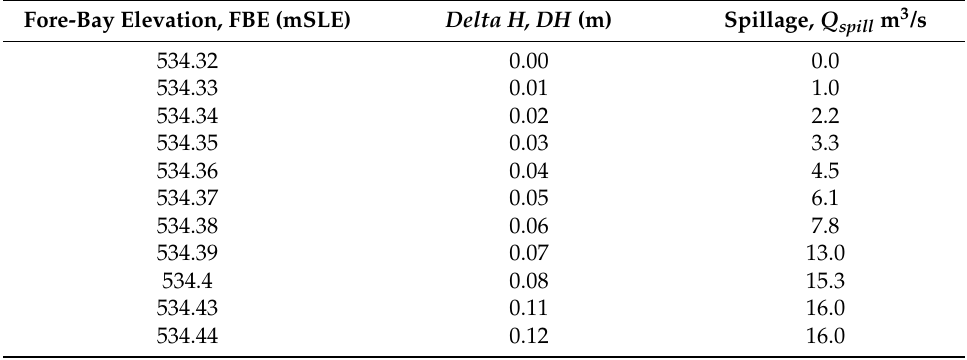
Table 1. Spillage versus delta H.